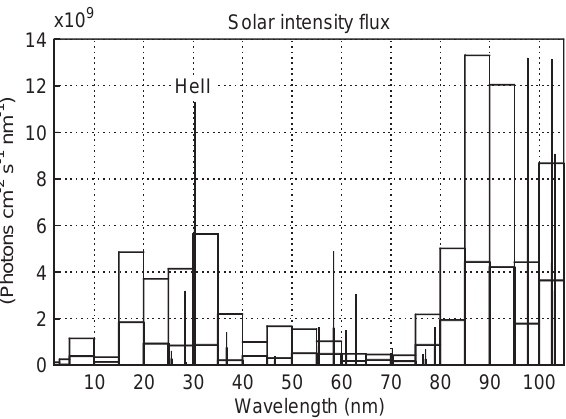
Fig. 7. The model for the solar intensity flux (Torr and Torr, 1985). The thin line is for solar maximum (F10.7 = 243) and the thick line for solar minimum (F10.7 = 68). The solar flux for any arbitrary F10.7 is deduced by interpolation between theses two references fluxes